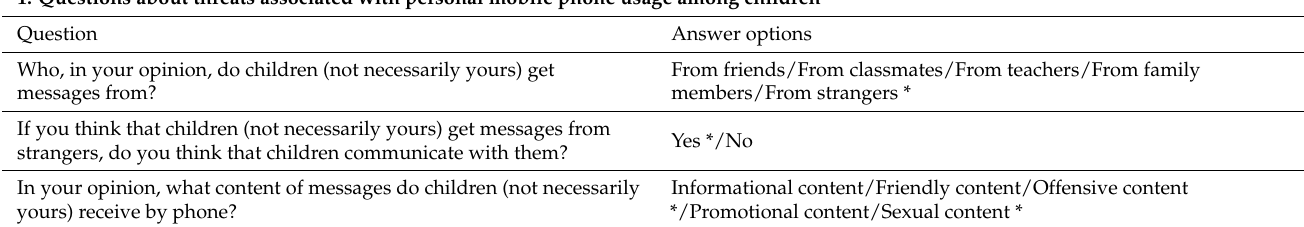
Table 1. Questions of the questionnaire about threats associated with personal mobile phones usage among children and parental control measures taken in order to control children’s usage of mobile